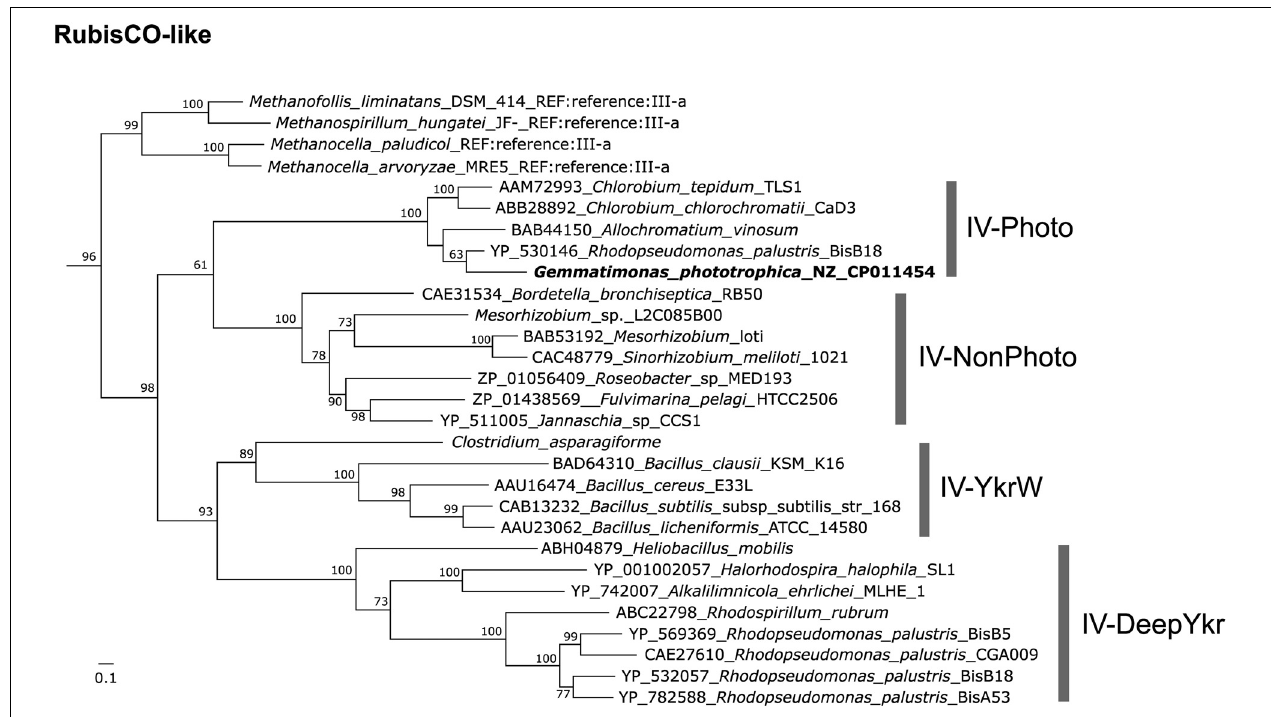
FIGURE 8 | Maximum-likelihood tree of RubisCO-like protein (RLP) gene (GenBank accession no. WP_026848175) in Gemmatimonas phototrophica . RubisCO sequences collected and classified by Jaffe et al. (2019) were used as references. Bar represents amino acid residue substitution rate. Bootstrap values between 0.5 and 1 are shown on the